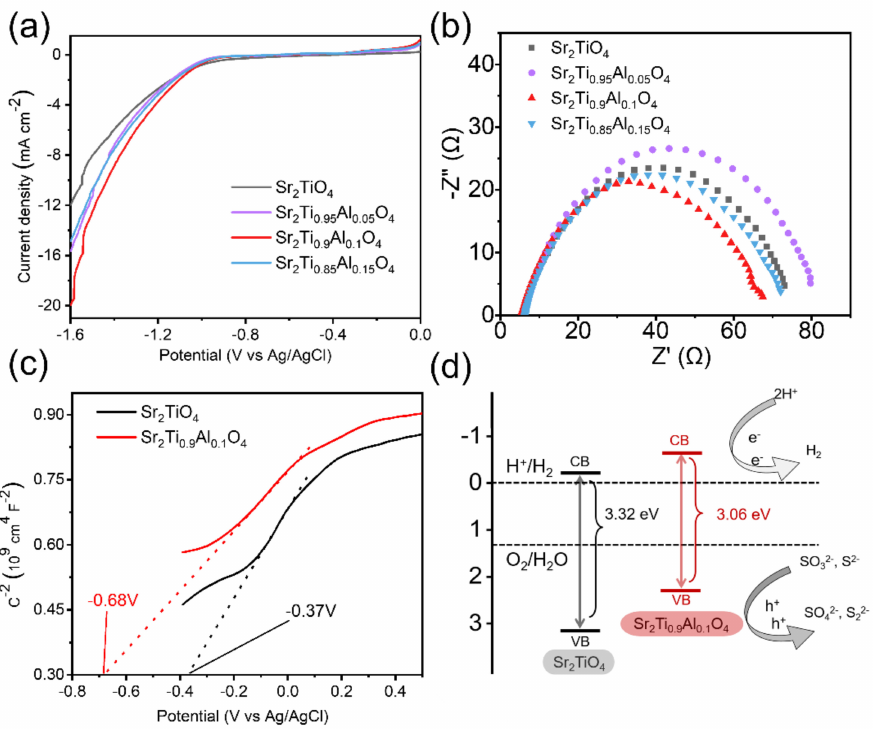
Figure 8. ( a ) LSV curves and ( b ) EIS spectra of Sr 2 Ti 1 − x Al x O 4 (x = 0, 0.05, 0.1, and 0.15). ( c ) MS curves and ( d ) schematically illustrated band structures of Sr 2 TiO 4 and Sr 2 Ti 0.9 Al 0.1 O 4